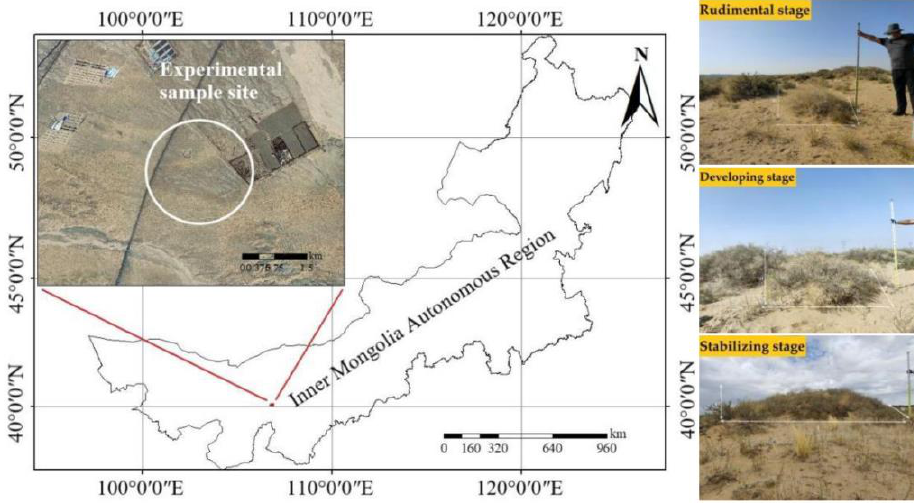
Figure 5. N. tangutorum in West Ordos Nature